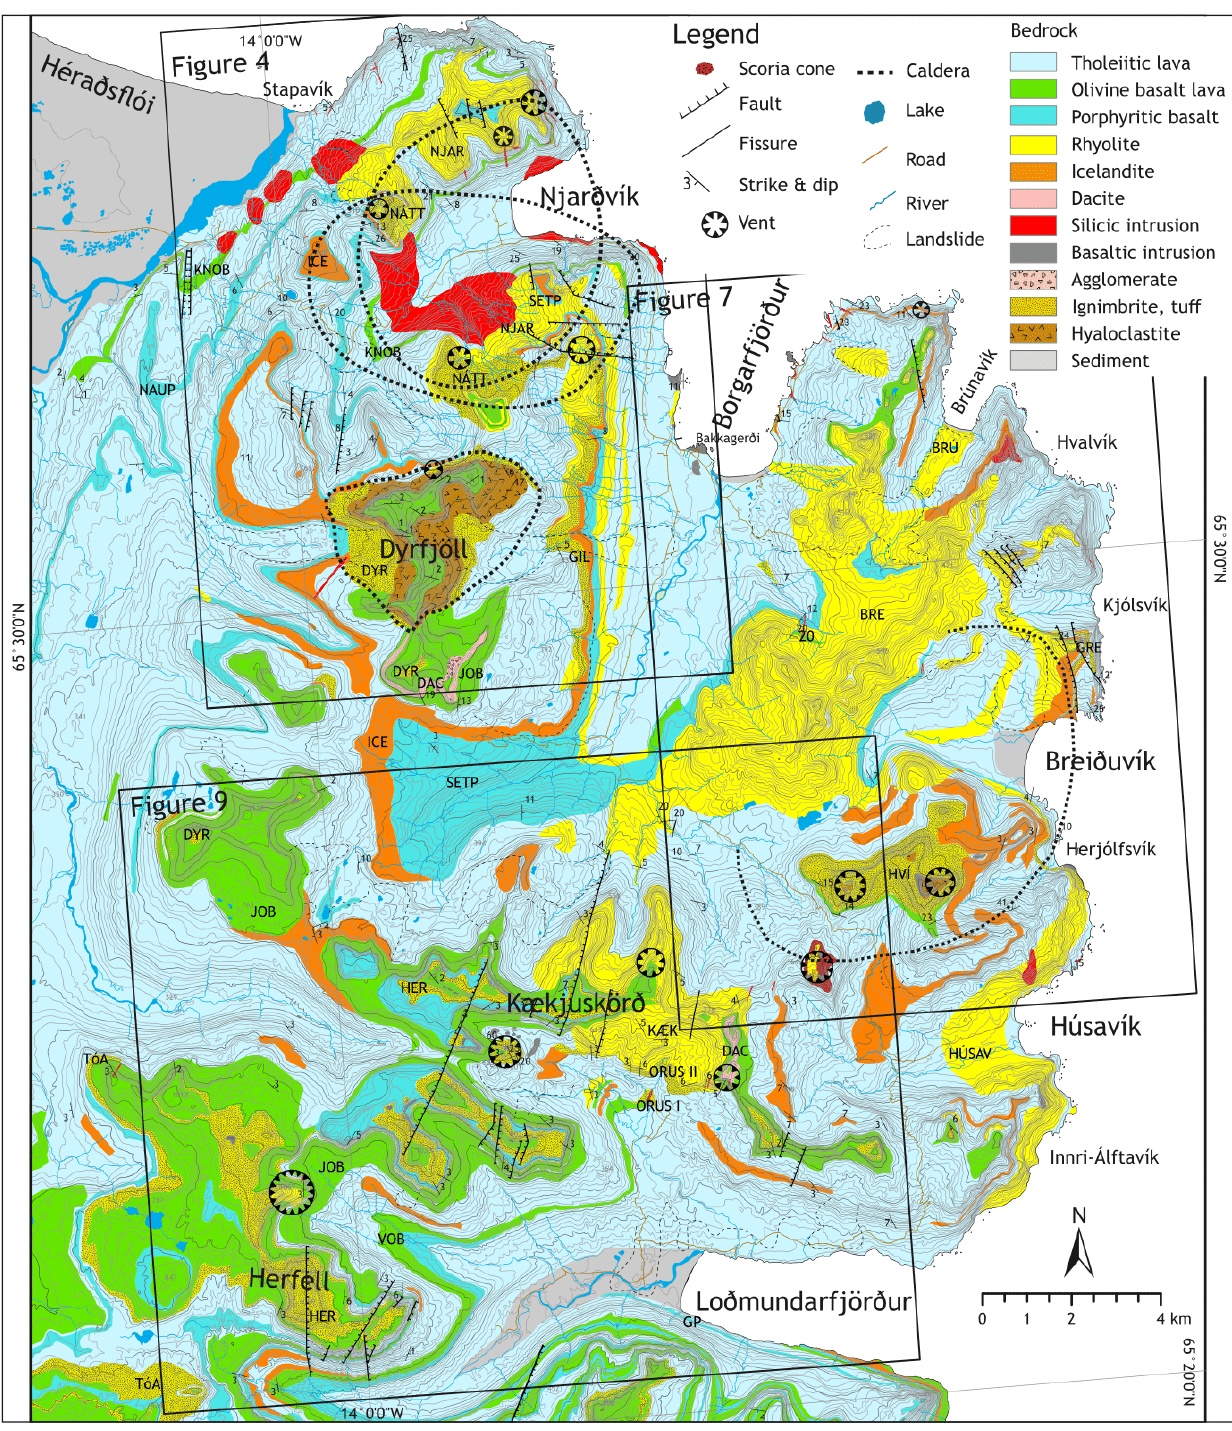
Figure 3: Geologial map of the Borgarfjörður–Loðmundarfjörður (BEL) area. Boxes indicate the locations of the detailed maps in Figures 4, 7 and 9. For names of stratigraphic formations, see text and Figure 15. The area includes numerous thick debris sheets of landslides and/or rock glaciers that have not been differentiated [based on Hjartarson et al. 1978]. Map issued by the Icelandic Institute of Natural History. Map prepared with ArcGIS software. Base map: The National Land Survey of Iceland (IS50V). Map projection: Lambert Conformal Conic (ISN93). Toponym: National Land Survey of Iceland. Cartography: Birgir Vilhelm